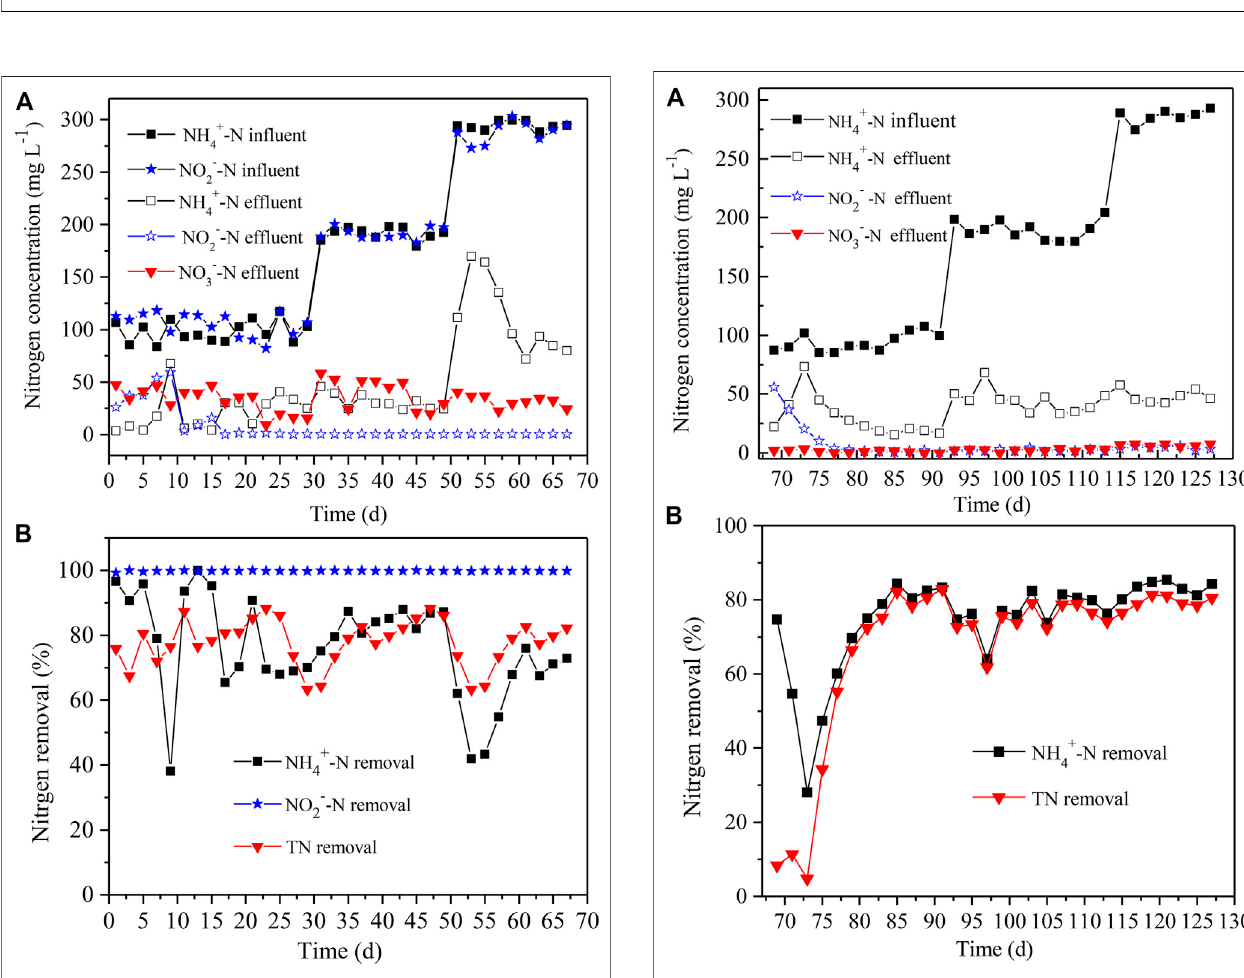
Frontiers in Bioengineering and Biotechnology |